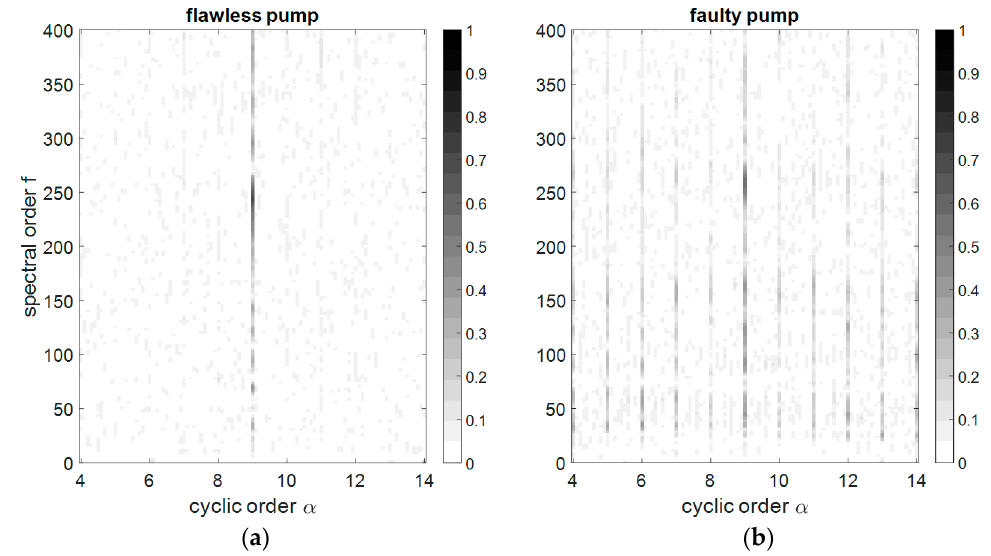
Figure 16. SCD around the cyclic order 9 for the signals acquired with sensor 2 at 2000 r/min and 250 bar ( ∆ α = 0.1, ∆ f = 2.5). ( a ) flawless pump; ( b ) faulty pump.